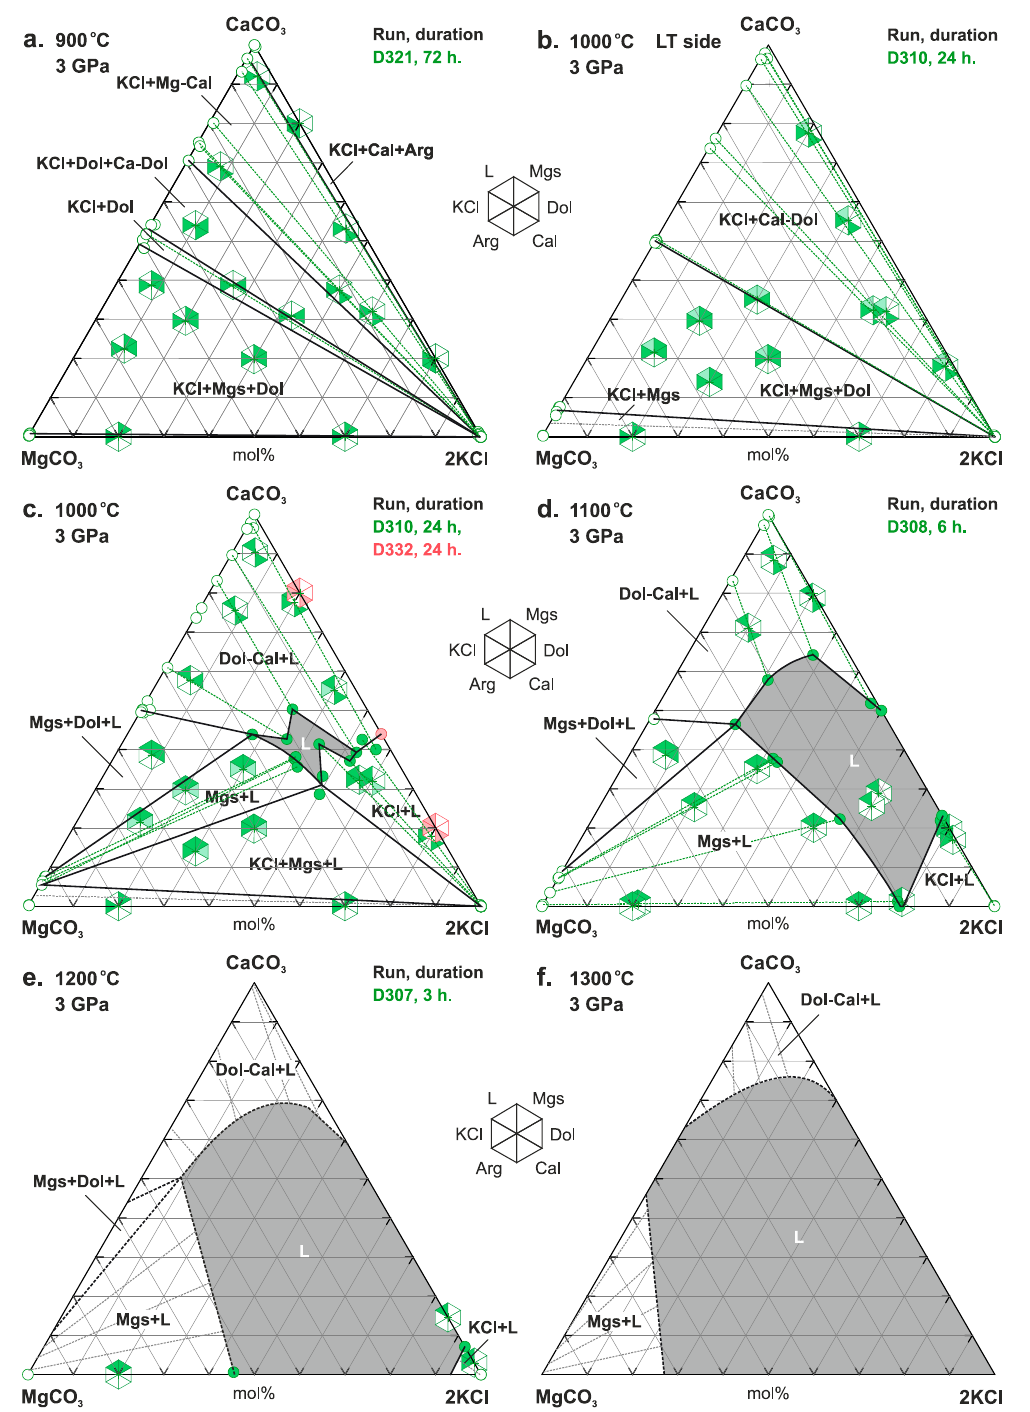
Figure 6. Isothermal sections of the KCl–MgCO 3 –CaCO 3 T-X diagram at 3 GPa. ( a ) 900 °C, ( b , c ) 1000 °C, ( d ) 1100 °C, ( e ) 1200 °C, and ( f ) 1300 °C. Isothermal sections at 1200 and 1300 °C were constrained ( b , c ) 1000 ◦ C, ( d ) 1100 ◦ C, ( e ) 1200 ◦ C, and ( f ) 1300 ◦ C. Isothermal sections at 1200 and 1300 ◦ C based on phase relations in the corresponding binaries. were constrained based on phase relations in the corresponding